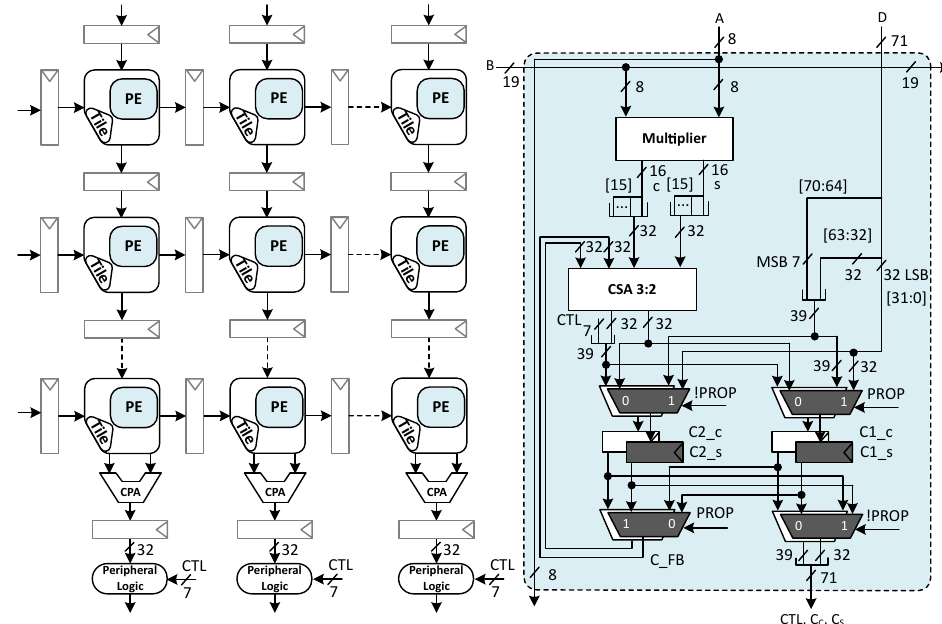
Figure 3. CPA-Factored Gemmini systolic array architecture with output stationary